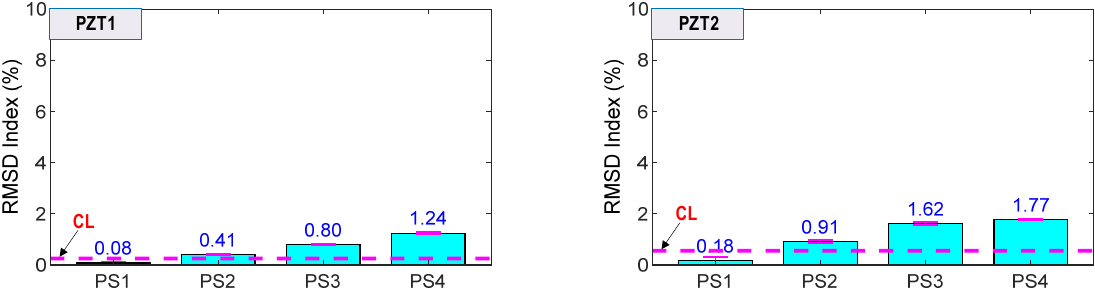
Figure 24. RMSD indices of impedance signals via surface-mounted under loading cases PS1~PS4.